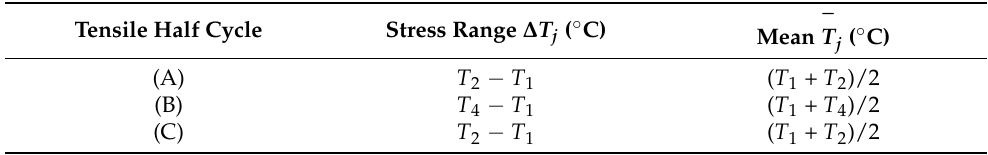
Figure 8. Example of rainflow counting for a reduced thermal profile. ( a ) Thermal stress history of a semiconductor. ( b ) Peak–valley history of a semiconductor using a reduced thermal profile. ( c ) Half cycles that start from tensile peaks. ( d ) Half cycles that start from compressive valleys. Table 9. Half-cycle counting for tensile peaks in a reduced thermal profile.